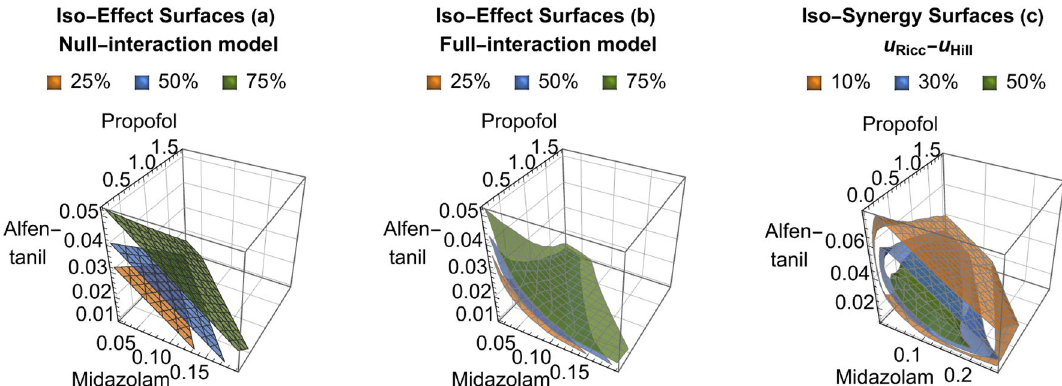
Figure 3. Iso-response surfaces for the ternary anesthetic mixture of propofol, midazolam and alfentanil at 25%, 50%, and 75% effect levels. Doses in [mg/kg]. Shown for the null-interaction ( a ) and the ’full-interaction’ ( b ) models. Their difference u Ricc − u Hill ( c ) shows iso-synergy surfaces at 10%, 30% and 50%